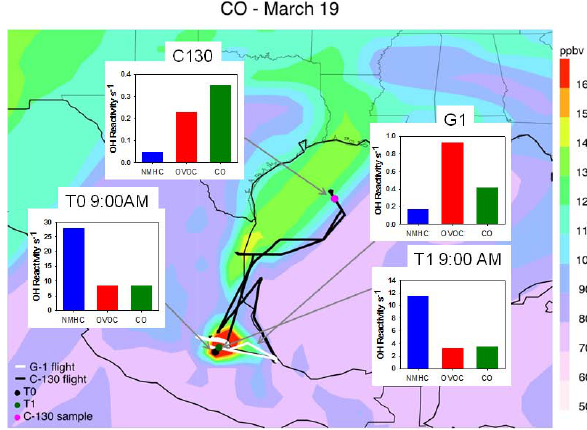
Fig. 10. MOZART depiction of the of the CO outflow from the 19 March 2006 plume. Superimposed on the plume are flight tracks from the G-1 on 18 March and from the C130 on 19 March. The G-1 intercepted the plume as it was emerging from the city during a transect that occurred between the times of 14:20 and 15:20 local time on the 18th and the C-130 which intercepted the plume on the afternoon of the 19th. The OH reactivity distributions in terms of NMHCs, OVOCs, and CO at 09:00a.m. are shown for the T0 and T1 sites, the G-1 during the transect, and the C130 during the plume interception that occurred at the furthest point from the